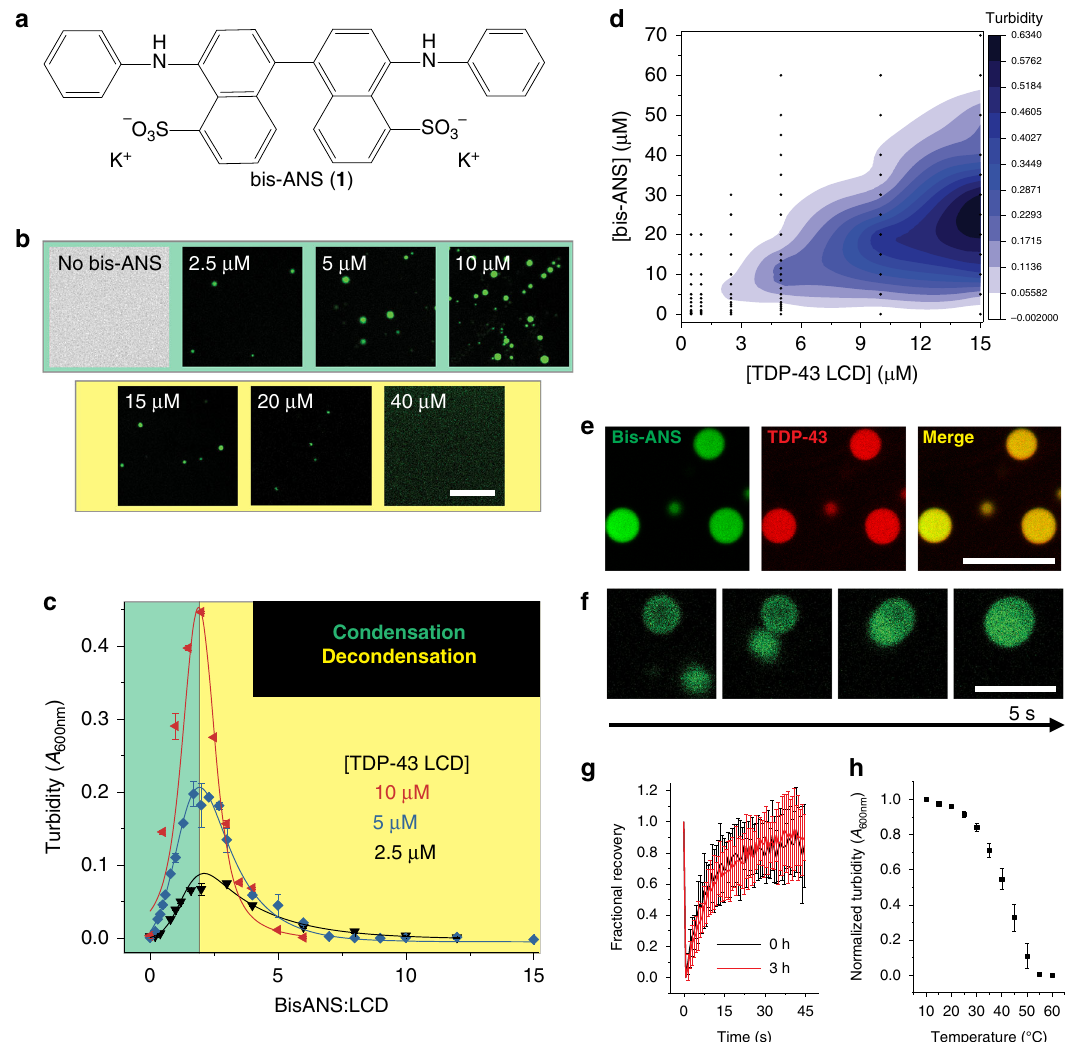
Fig. 1 Bis-ANS induces LLPS of the TDP-43 LCD. a Chemical structure of 4,4 ′ -dianilino-1,1 ′ -binaphthyl-5,5 ′ -disulfonic acid (bis-ANS, 1 ). b Representative fl uorescence microscopy images for TDP-43 LCD (5 μ M) in the presence of different concentrations of bis-ANS. c Representative turbidity traces for multiple protein concentrations as a function of bis-ANS to TDP-43 LCD molar ratio ( n ≥ 3 technical replicates across three separate preparations for 5 μ M protein, n = 3 technical replicates for 2.5 and 10 μ M). d Turbidity contour plot (phase diagram) depicting the relationship between bis-ANS and TDP-43 LCD concentration. Data points used for contouring are shown in black. e Colocalization fl uorescence microscopy images of liquid droplets formed by TDP- 43 LCD in the presence of bis-ANS at a ratio of 2:1. Protein solution was doped with Alexa Fluor 594-labeled TDP-43 LCD (100 nM). f Representative fusion events between TDP-43 liquid droplets formed in the presence of bis-ANS. Experiments in ( e , f ) were performed using untagged (shown) and His- tagged protein with similar results. g FRAP of bis-ANS-containing droplets ( n ≥ 14 individual droplets across three independent experiments) depicting rapid recovery within 45 s. Experiments were performed immediately after droplet formation and at 3 h. h Droplets formed by bis-ANS and TDP-43 LCD are disrupted at high temperatures ( n = 3 technical replicates). All experiments were performed using a 20 mM potassium phosphate buffer, pH 6.0. Scale bars: 10 μ m. All data are presented as mean values ± standard